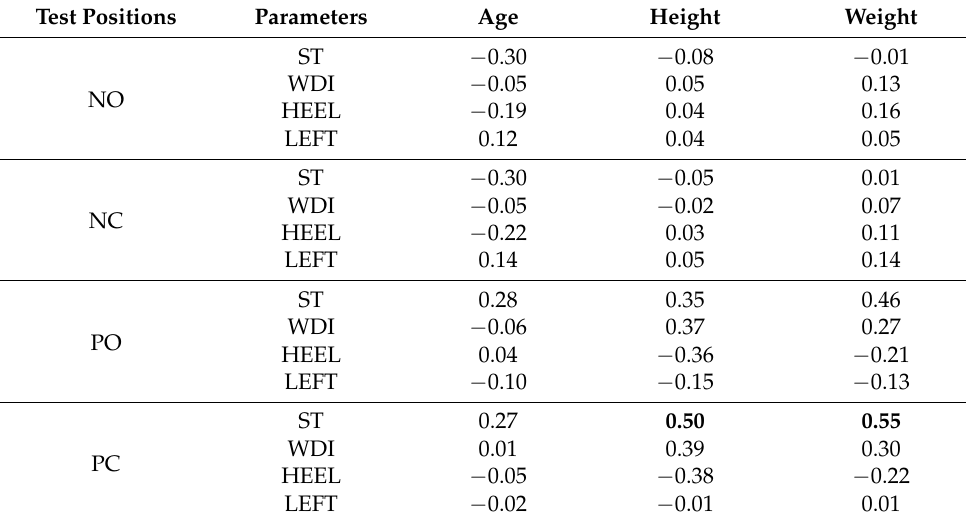
Table 3. Bivariate correlations (r) between anthropometric/demographic and interactive